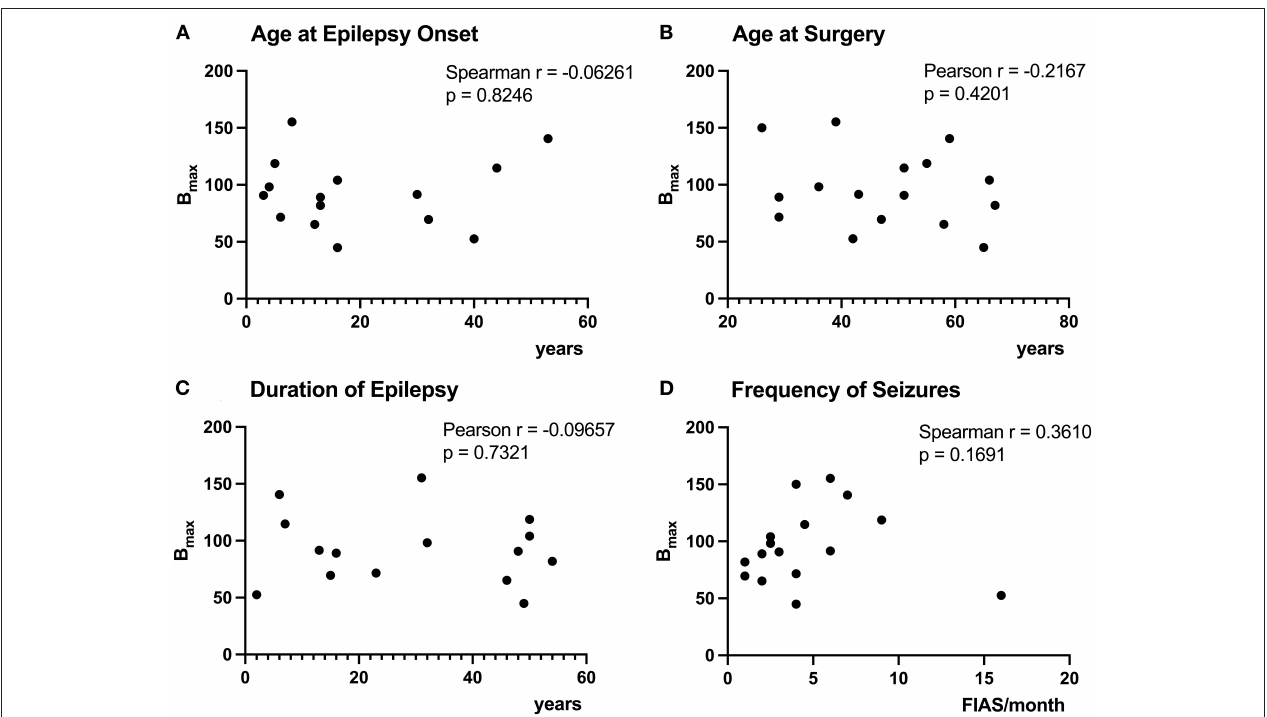
FIGURE 3 | Correlation of [ 3 H]ABP688 B max and clinical demographics. Correlations between receptor densities (B max ; in fmol/mg) and age at epilepsy onset (A) , age at surgery (B) , duration of epilepsy (C) , and frequency of seizures (focal impaired awareness seizures, FIAS, per month in the year prior to surgery) (D) are presented. The age at epilepsy onset was uncertain for P10, therefore, the patient was excluded from the analyses of B max with age at epilepsy onset and epilepsy duration (A,C) . All correlations were non-significant with p > 0.05.